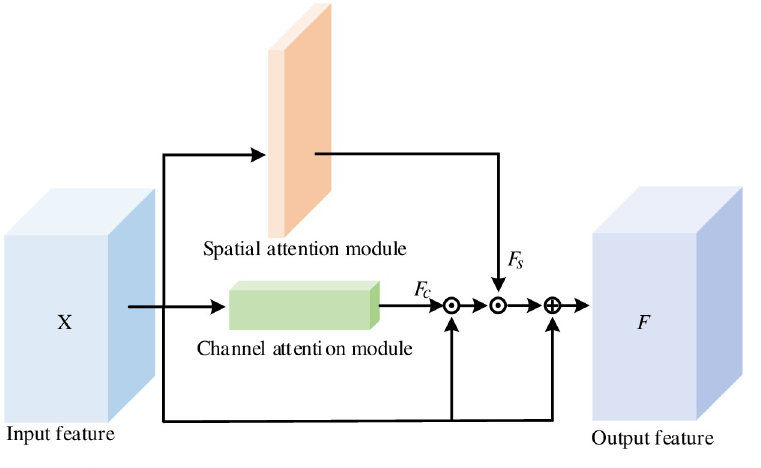
Fig 4. Multi-attention